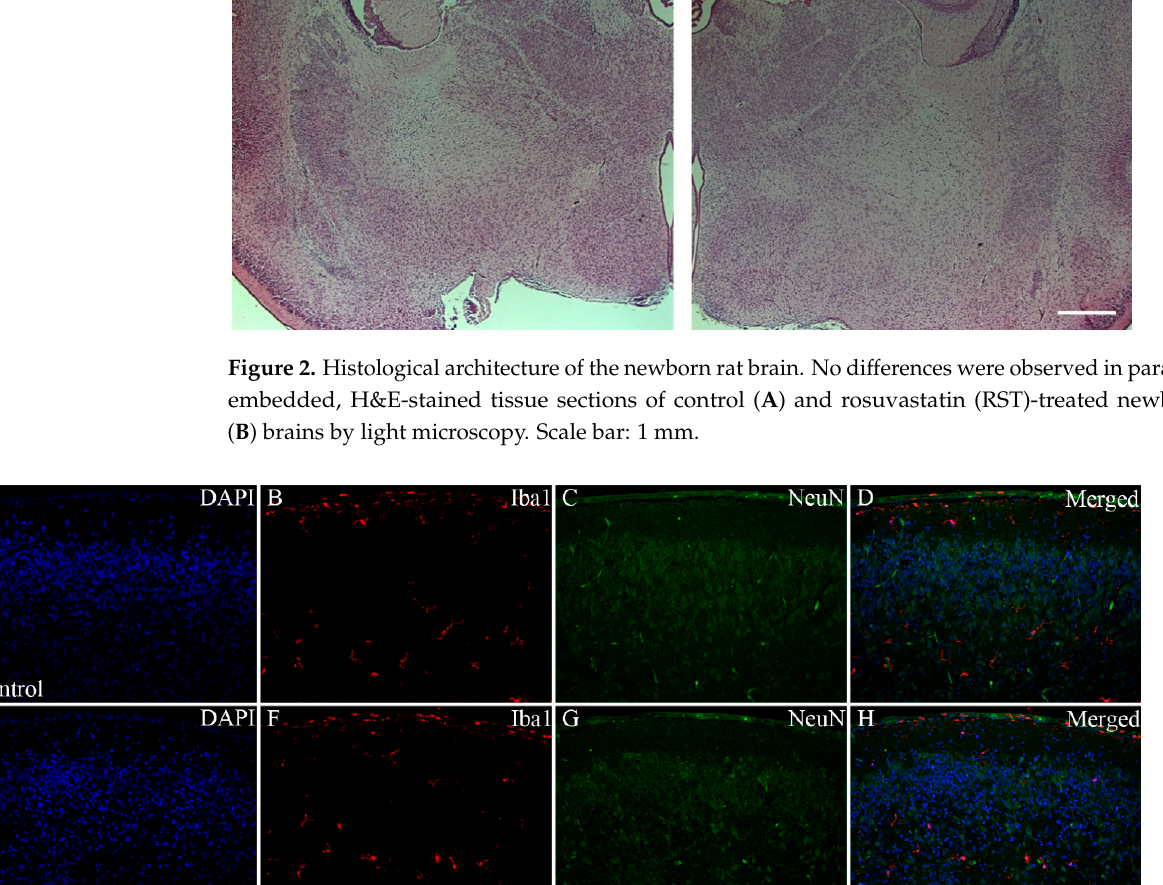
Figure 3. Double immunofluorescent staining for Iba1 and NeuN. Microglia were labeled with the anti-Iba1 antibody/Alexa Fluor 568 goat anti-rabbit IgG complex (red), whereas neurons were detected with the anti-NeuN antibody/Alexa Fluor 488 goat anti-mouse IgG complex (green). Cell nuclei were labeled with DAPI (blue). Representative pictures with lower (20 × ) magnification show that prenatal exposure to RST did not cause abnormalities in the cytoarchitecture by light microscopy. The ratio of microglia ( B , F ) to neurons ( C , G ) is similar between the control ( A – D ) and RST-treated ( E – H ) newborn brains. Scale bar: 100 µm.